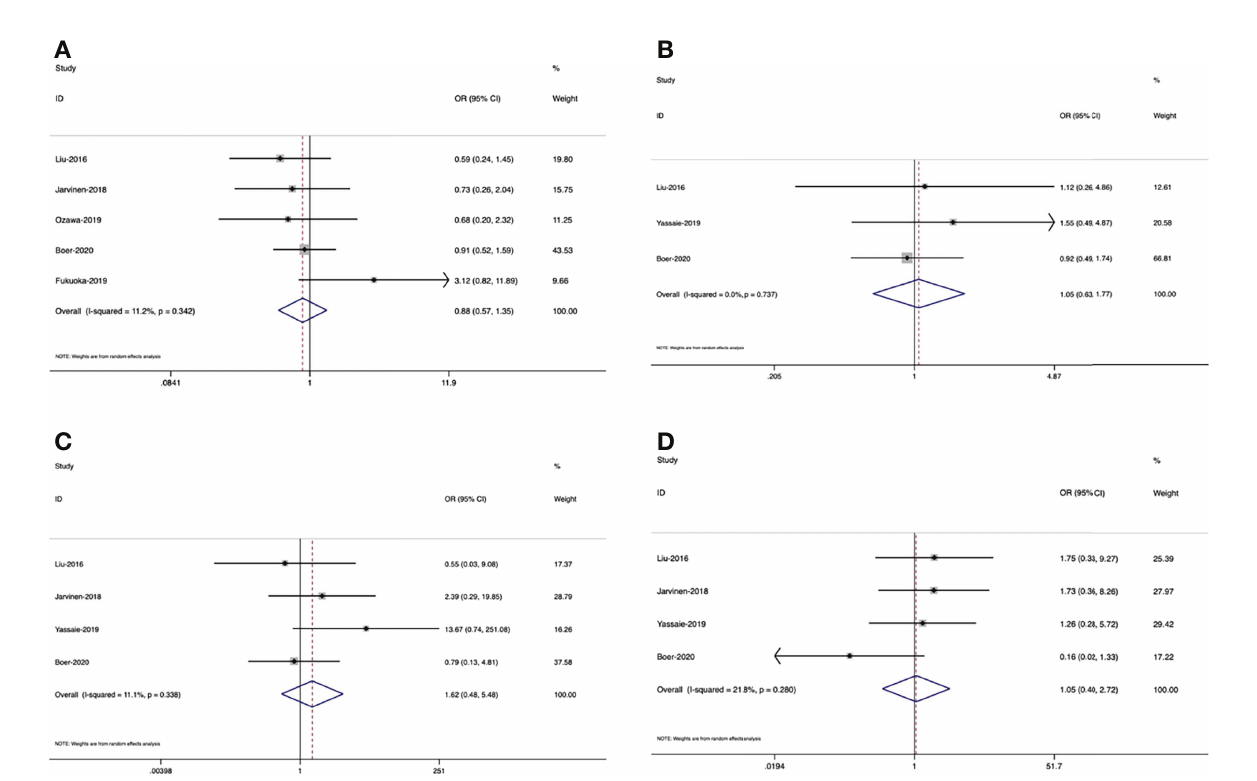
FIGURE 5 | Forest plots of the relationship between muscle loss during neoadjuvant therapy and (A) total complications, (B) anastomotic leakage, (C) pneumonia and (D)